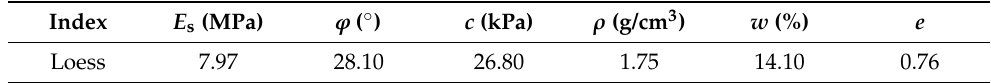
Table 3. Physical indexes of soil (mean).